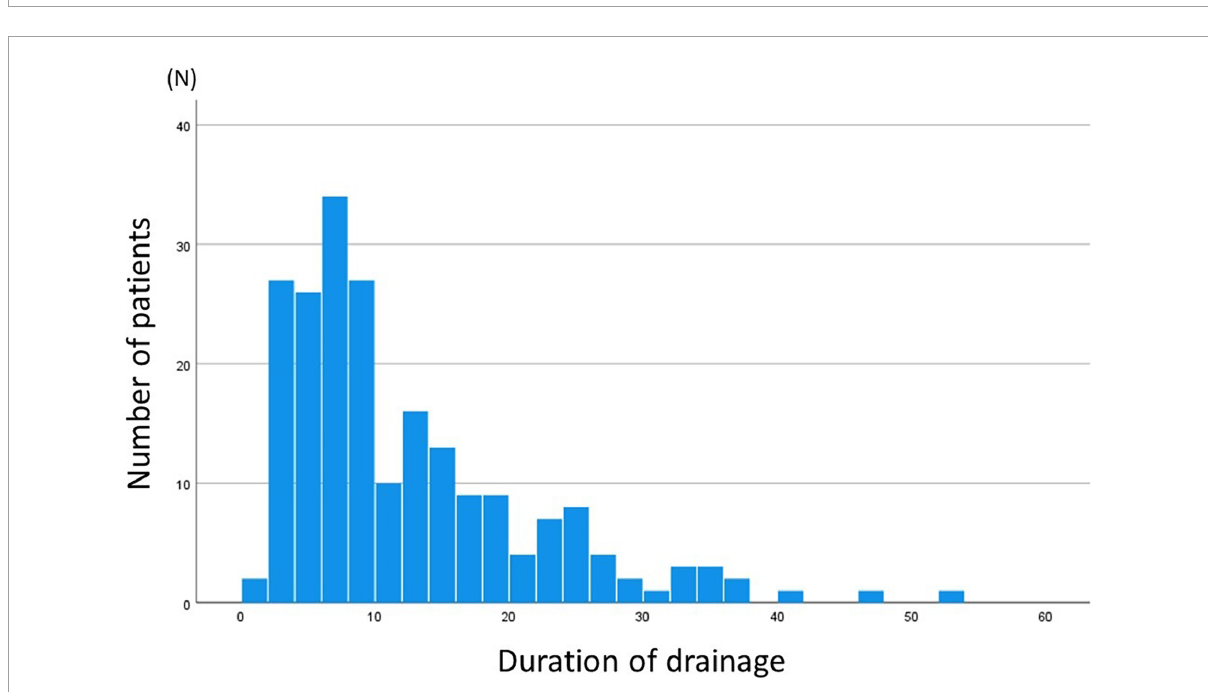
FIGURE2 Histogram of duration of drainage. Median duration of drainage was at 9 (IQR = 5–17, minimum 1 and maximum 52) days.